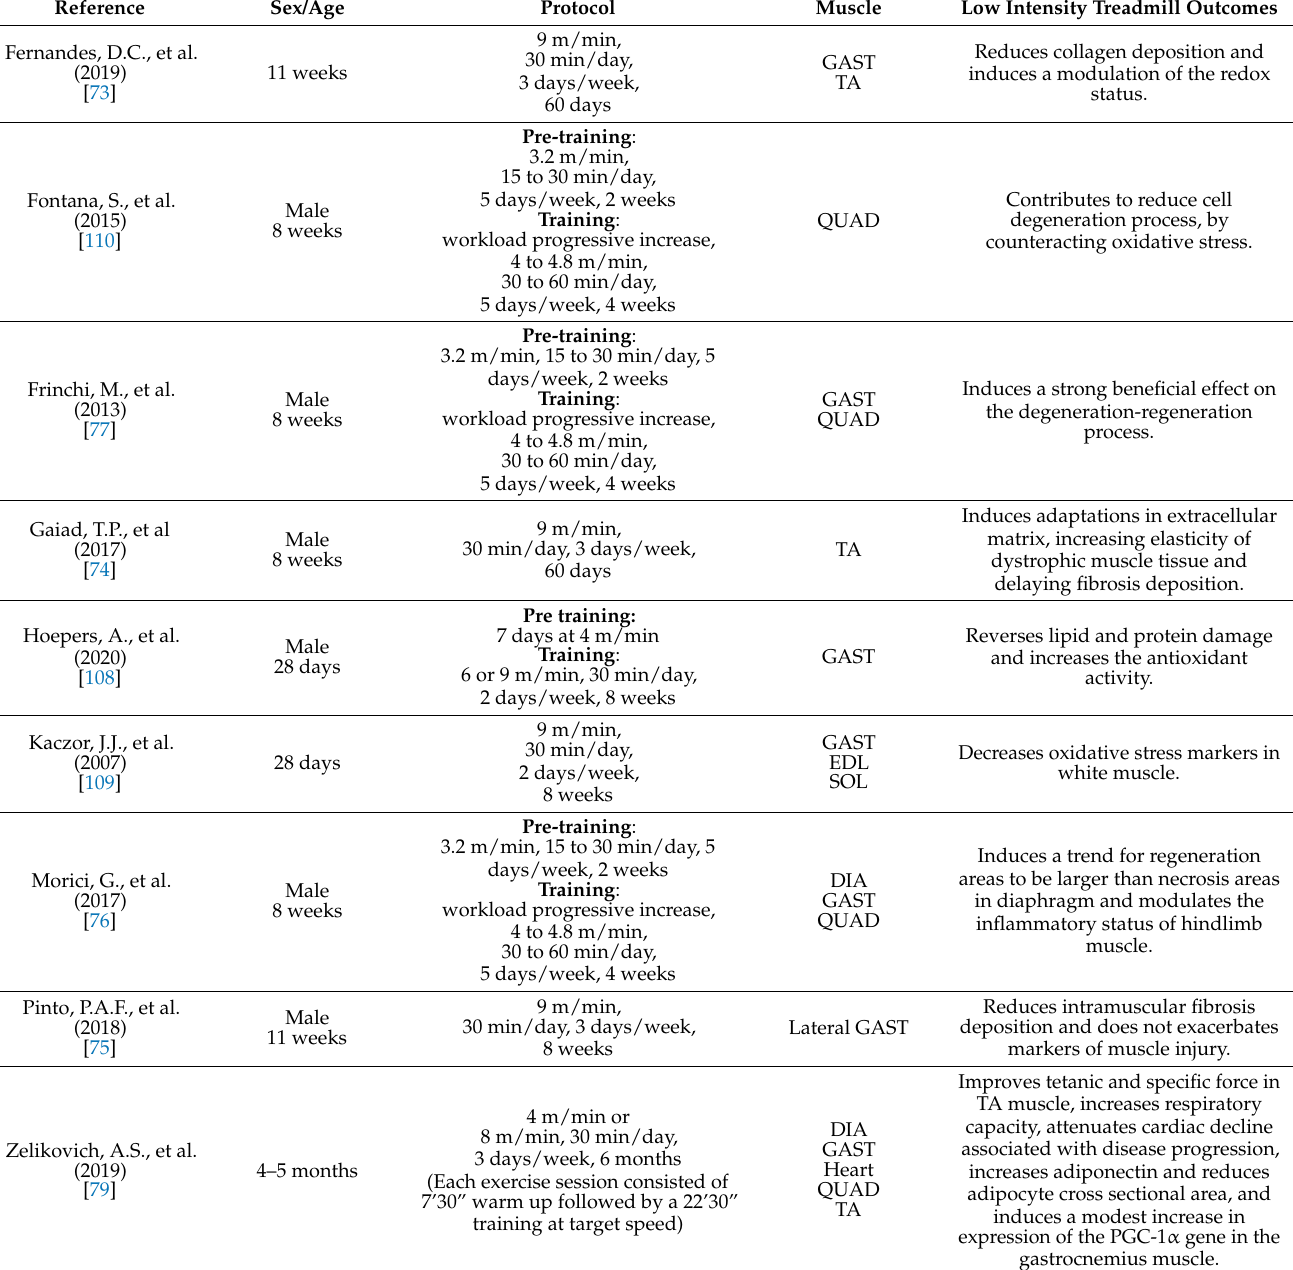
Table A5. Beneficial effects of low intensity treadmill running on mdx